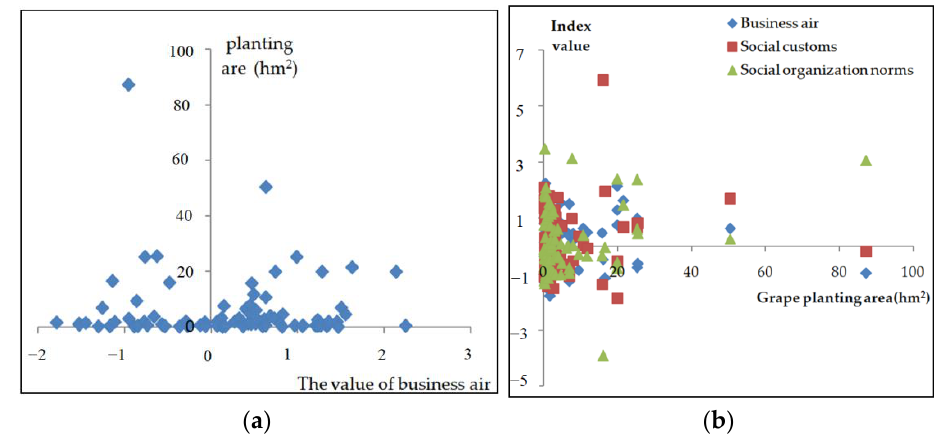
Figure 5. Social norms and grape planting area of villages. Table 4. Impact of social norms on grape planting in